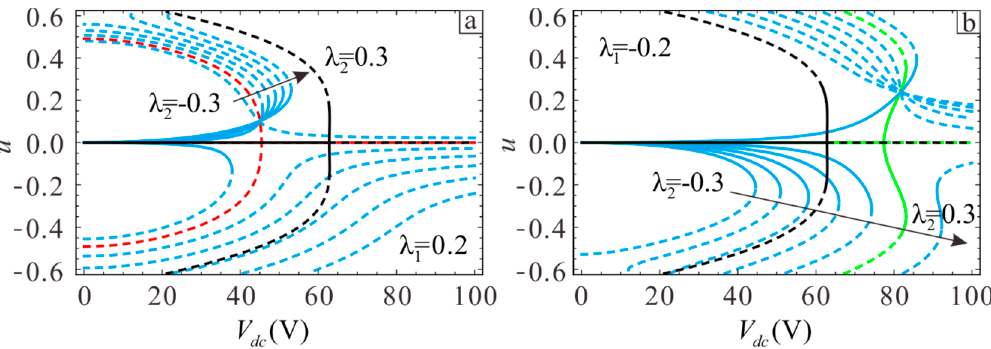
Figure 6. Influence of the section parameters on static pull-in: ( a ) λ 1 = 0.2 and ( b ) λ 1 = − 0.2. Solid lines show stable solutions and dashed lines show unstable solutions. Blue lines indicate asymmetry, while red and green lines indicate symmetry. The black line indicates the case where the section parameters are λ 1 = λ 2 = 0.